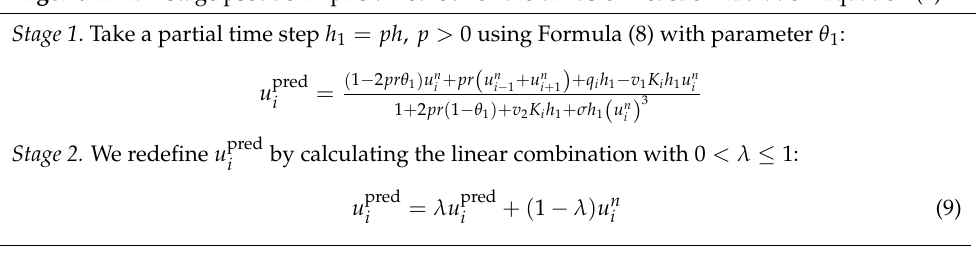
Algorithm 4: 2-stage pseudo-implicit method for the diffusion-reaction-radiation Equation